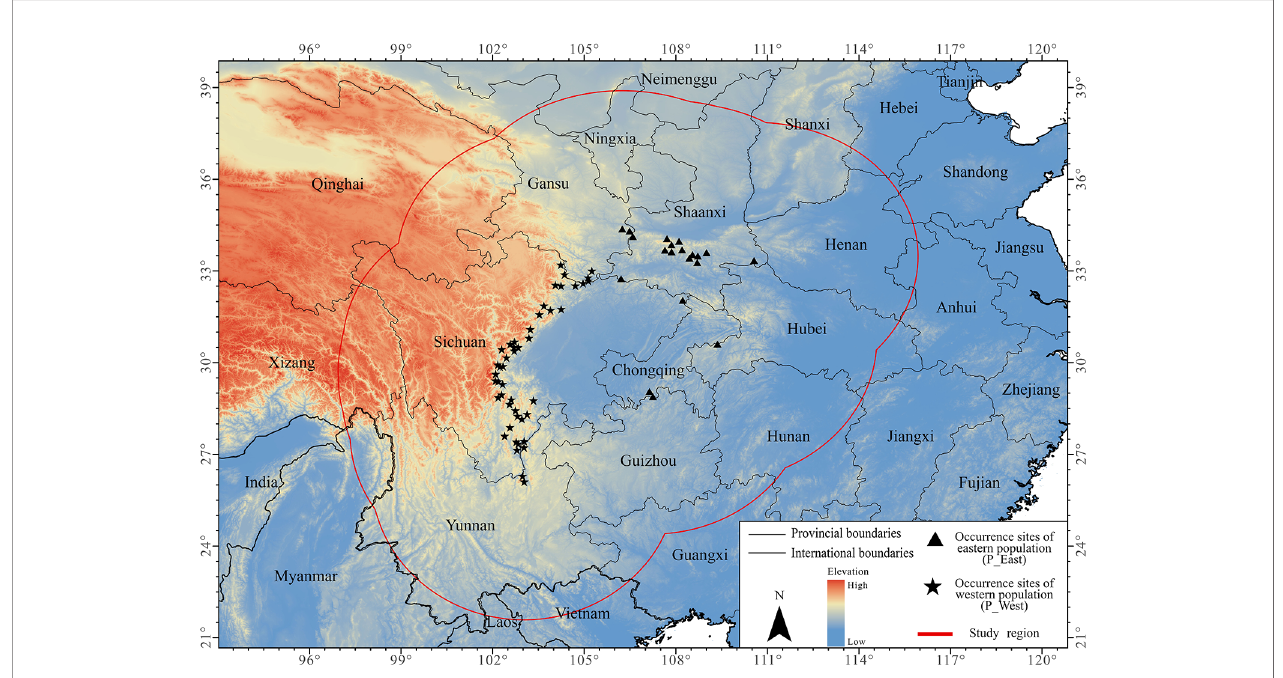
FIGURE 1 | Occurrence sites of Paeonia mairei . All occurrence sites were divided into two populations based on geographical locations: sites in Hengdaun Mountains were referred to as western population (P_West) and sites in Qinling Mountains were referred to as eastern population